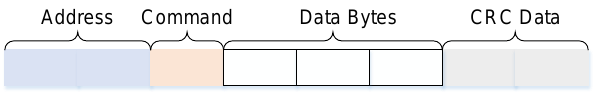
Figure 6. The structure for the data frame, CRC: cyclic redundancy check.